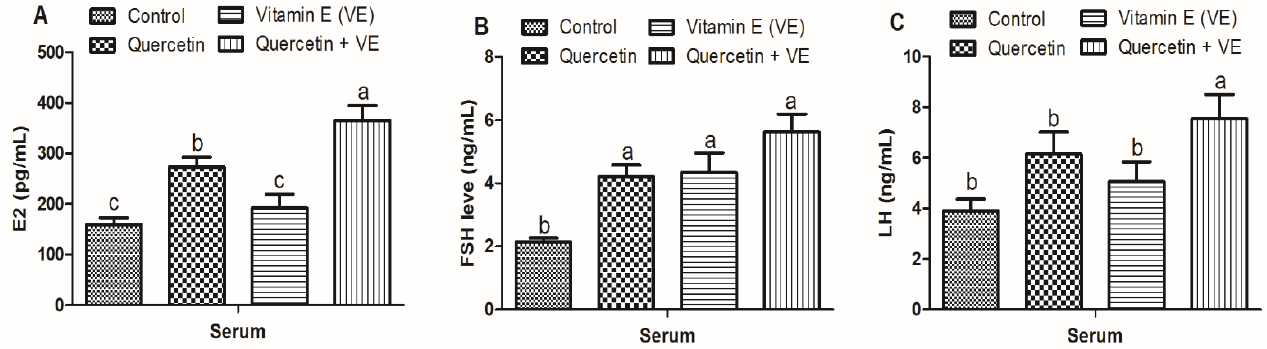
Figure 6. Effects of quercetin (Q), vitamin E (VE), and their combination (Q + VE) on serum hormone contents of aging breeder hens. Levels of E2 ( A ), FSH ( B ), and LH ( C ). The values are presented as the mean ± SD. Bars without the same letter differed significantly ( p < 0.05).